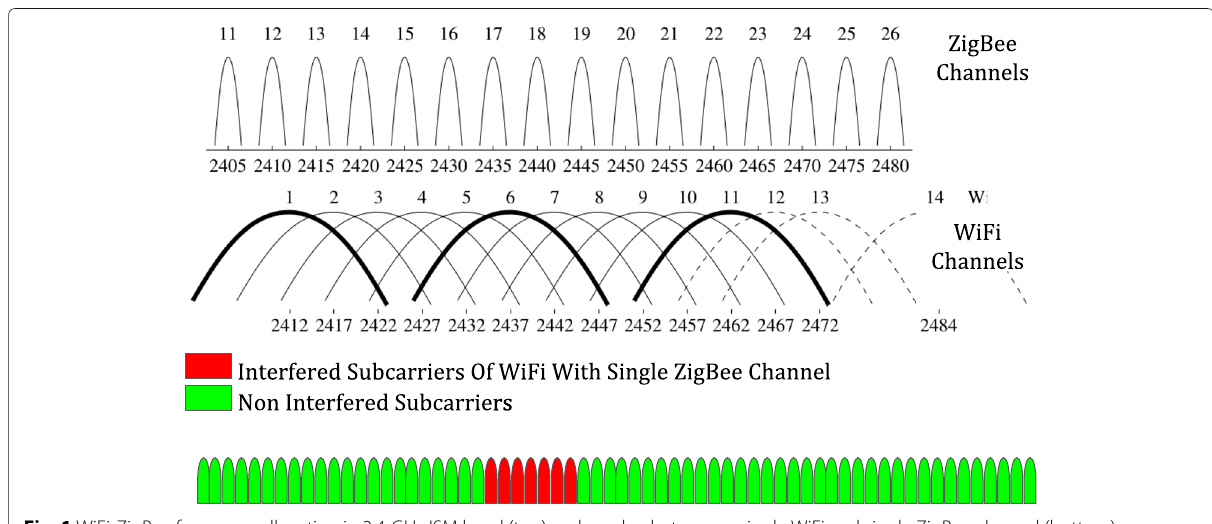
Fig. 1 WiFi-ZigBee frequency allocation in 2.4-GHz ISM band (top) and overlap between a single WiFi and single ZigBee channel (bottom)